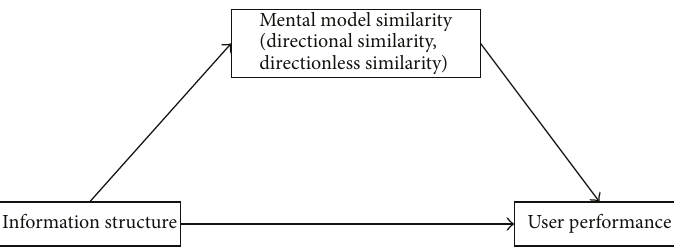
Figure 1: The mediation effect of mental model similarity in the relation between information structure and user performance.